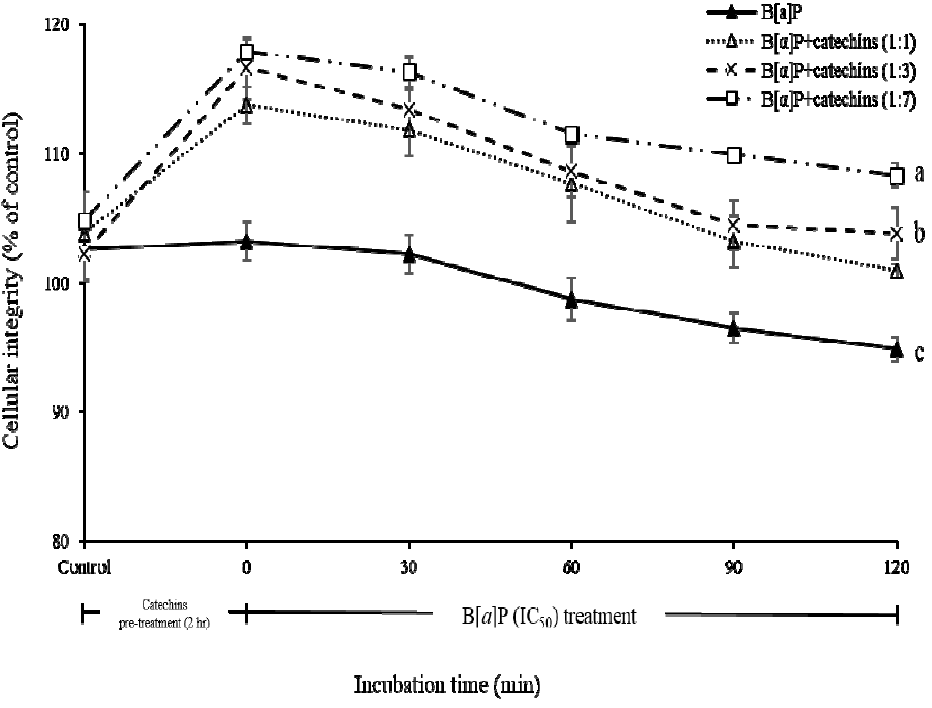
Figure 5. Cellular integrity of HBMECs in B[ α ]P after pre-treatment with di ff erent ratio of catechins. The values are mean ± SD in triplicate. a p < 0.01 as compared with control; b p < 0.05 as compared with control; c p < 0.01 as compared with control. Control indicates HBMECs treated by only DMEM without B[ α ]P and catechins.